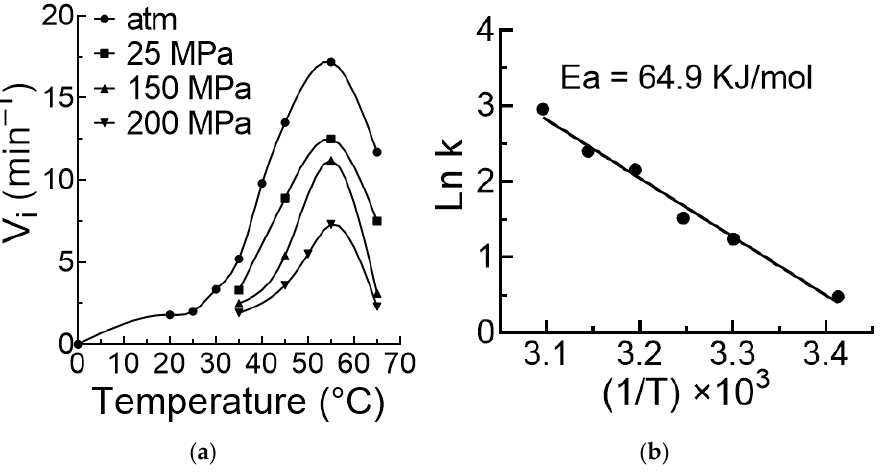
Figure 3. Effects of temperature on the ASBVd(–) self-cleavage reaction. ( a ) Rates of reaction as a function of temperature at different pressures. ( b ) Corresponding Arrhenius plot at atmospheric pressure providing the energy of activation of the reaction.